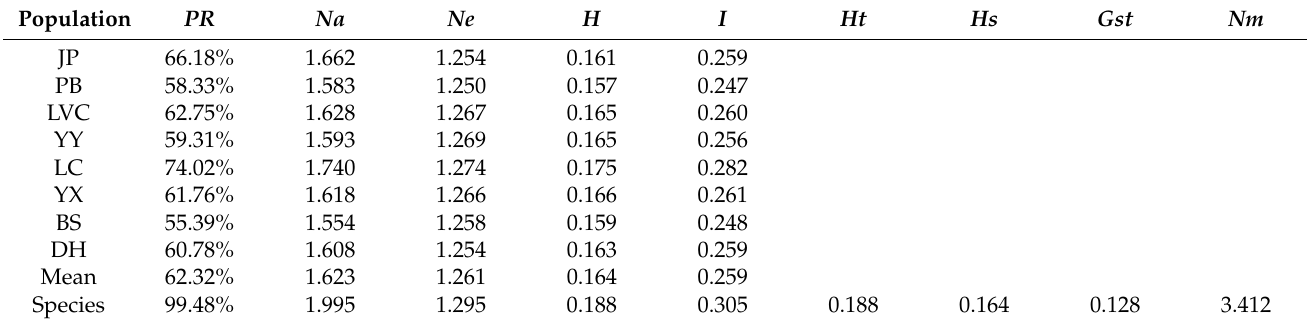
Table 5. Genetic diversity of A. tsao-ko populations from CDDP markers.